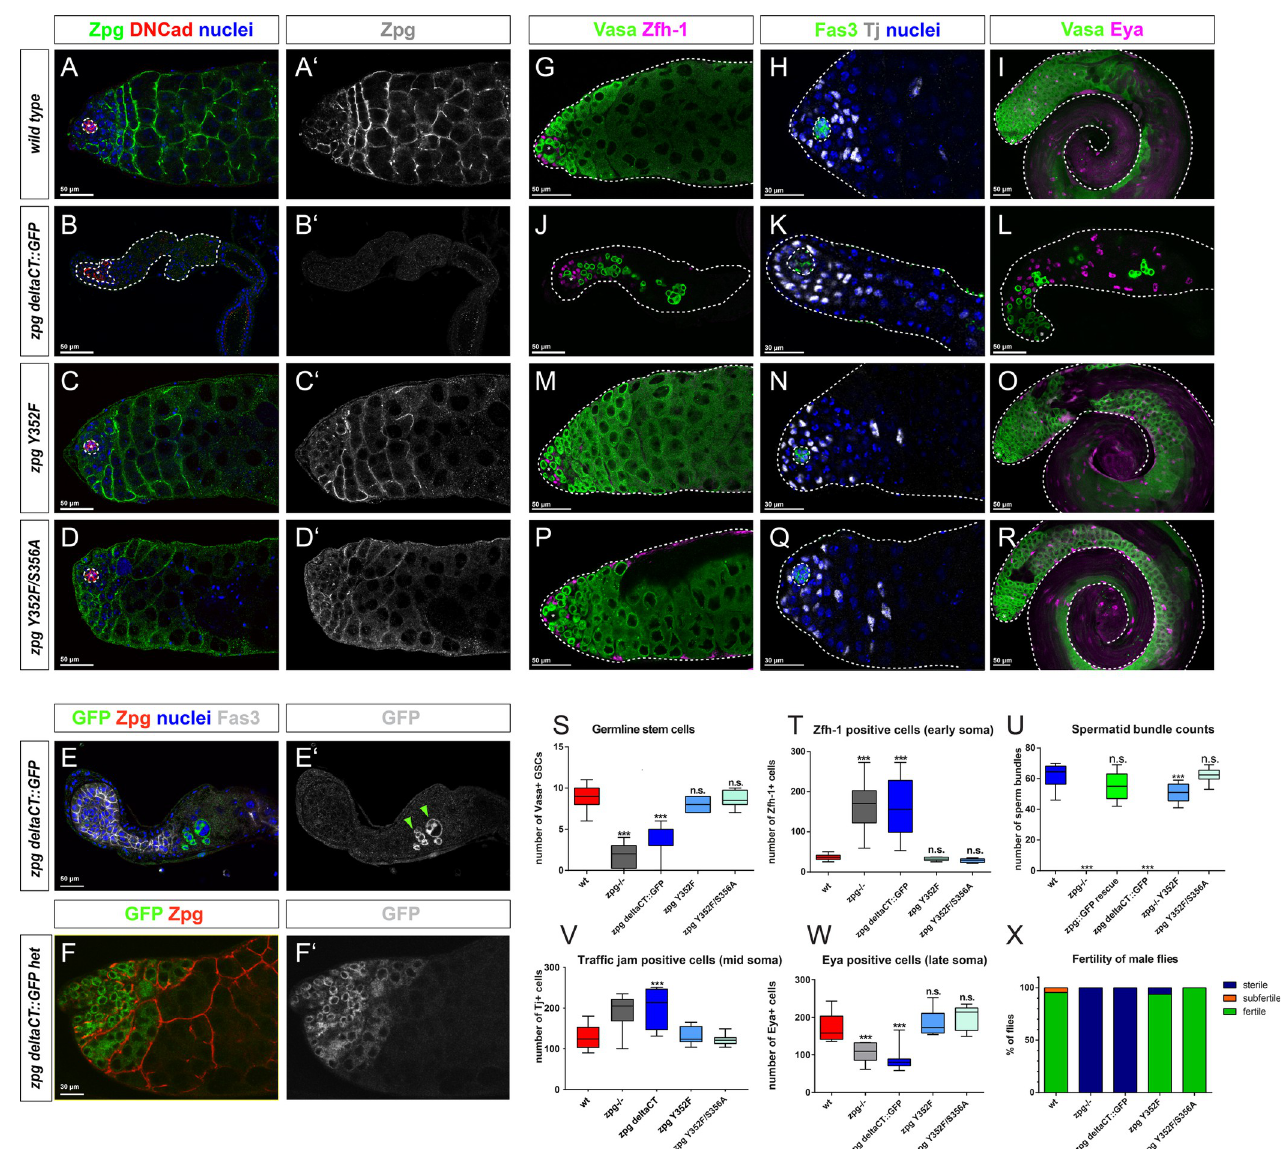
Fig 3. The C-terminus of Zpg is crucial for protein function, while C-terminal phosphorylation sites are dispensable. Zpg staining (green in A-D; single channels in grey in A’-D’) is absent in zpg mutants rescued with Zpg containing a C-terminal deletion ( zpg deltaCT::GFP) (B, B’), as the antibody binding site is deleted. zpg deltaCT::GFP mutant testes are severely reduced in size and the hub (DN-Cadherin, red) is enlarged. In zpg mutants expressing a genomic rescue construct containing mutations in phosphorylation sites (C, C’: zpg Y352F, D, D’: zpg Y352F/S356A), Zpg staining normally localizes to the germline-soma boundaries (as indicated by arrows). Wt control is shown in A, A’. Nuclei are highlighted in blue. (E-F) localization of the GFP tag in testes when zpg deltaCT:: GFP is expressed in the null mutant background (E-E’) and in flies with one copy of endogenous zpg (F-F’). In testes of both genotypes, the GFP signal accumulates intracellularly. Compared to wt (G, I), significantly less Vasa+ early germ cells (green) can be detected in testes of zpg deltaCT::GFP flies (J, L), whereas no difference to wt was seen in zpg Y352F (M, O) and zpg Y352F/S356A mutants (P, R). The number of Zfh-1+ cells (wt shown in F) and Tj+ cells (wt shown in H) was higher in zpg deltaCT::GFP testes (J, K), but not in the phospho mutants (M-Q). Less cells expressing the late somatic marker Eya were detected in testes of zpg deltaCT::GFP flies (L) than in wt (I), but no change was found in the phosphorylation mutants (O, R). This indicates defective germ cell and somatic cell differentiation in zpg deltaCT::GFP flies, but not in the two phosphorylation mutants. Quantification of (S) germline stem cells (GSCs), (T) Zfh-1-positive cells, (U) Tj-positive cells, (V) Eya-positive cells, (W) spermatid bundles, and (X) fertility, shows loss of function upon deletion of the C- terminus, but no defects in phosphorylation mutants. Scale bars represent 30–50 μ m, as indicated above them. p-values are for difference from wildtype and indicated by asterisks with � p < 0.05, �� p < 0.01, ��� p < 0.001.